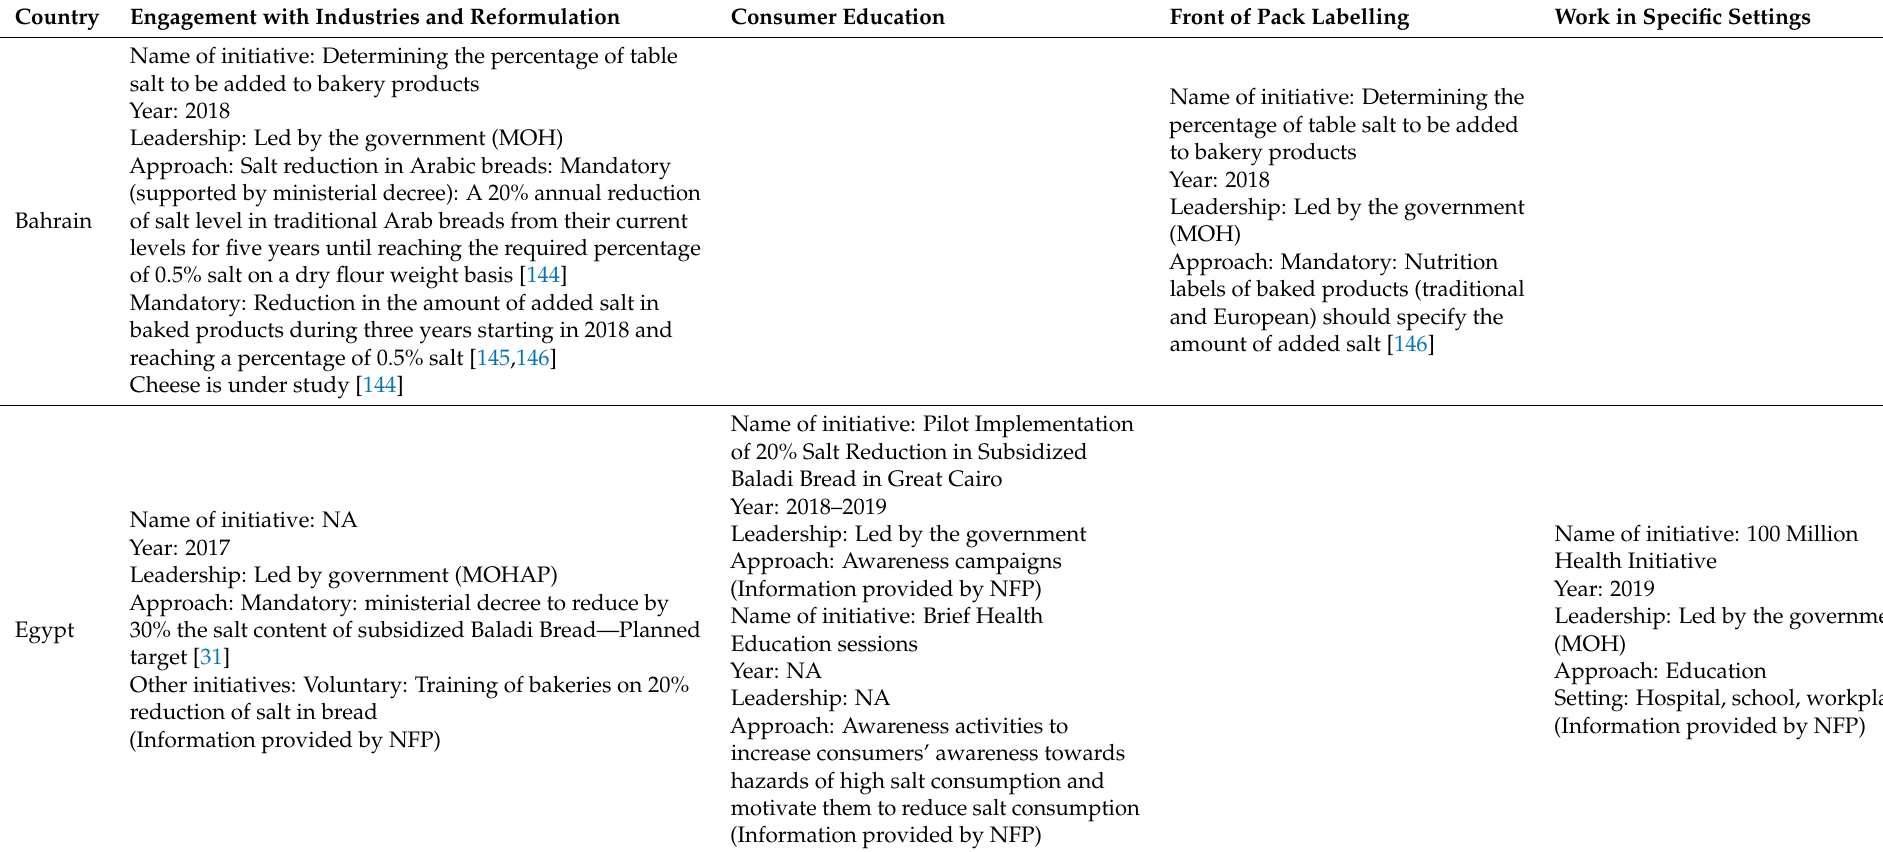
Table 1. Salt reduction implementation strategies in countries of the